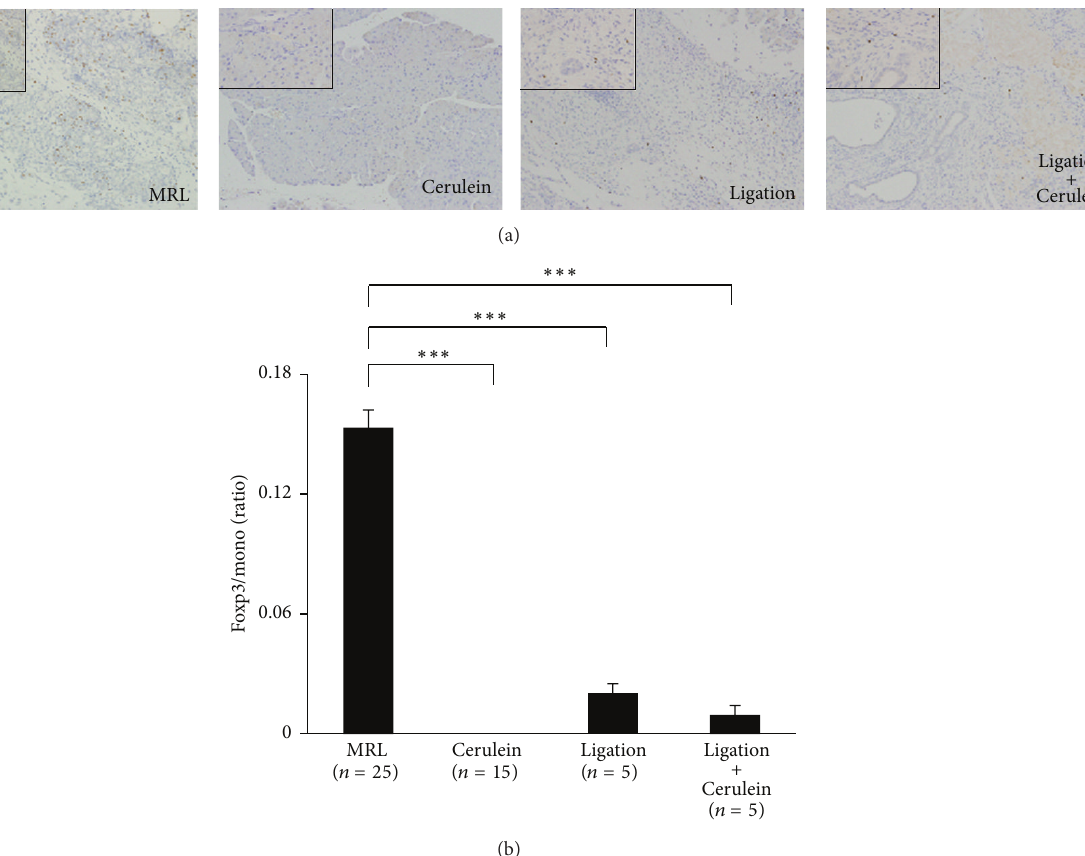
Figure 7: Representative immunostaining of Foxp3 in the pancreases (a) and the ratios of Foxp3/mono (Foxp3-positive cells/infiltrated mononuclear cells) in the pancreases (b) of poly I:C-treated MRL/Mp mice at the age of 10–20 weeks and Cerulein-, Ligation-, and Ligation + Cerulein-treated mice at the same age. Abundant infiltration of Foxp3-positive cells was found among the lymphoid infiltrates in MRL/Mpmicepancreases,butnotinCerulein-treatedmice.InLigation-andLigation + Cerulein-treatedmice,Foxp3immunostainingofthe pancreas showed infiltration of few Foxp3-positive cells. The Foxp3/mono ratios in MRL/Mp mice were significantly increased compared with Cerulein-,Ligation-,andLigation + Cerulein-treatedmice. × 100magnification(largepanel), × 400(inset).Dataareexpressedasmean ± SEM; ∗∗∗ 𝑃 < 0.001